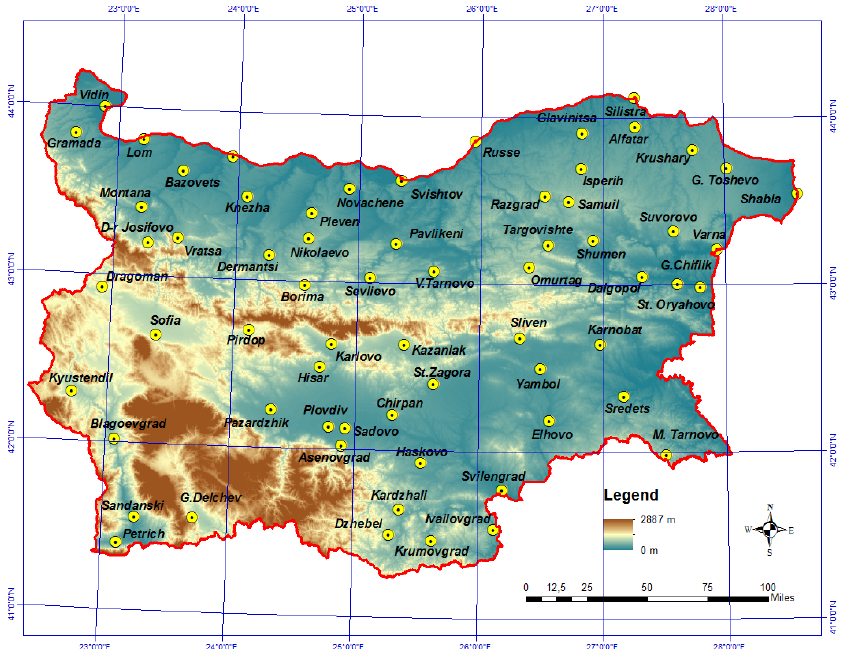
Figure 1. Meteorological stations distribution in the territory of Bulgaria using in the investigation. Table 1. Geographic coordinates—latitude, longitude, and elevation of 65 meteorological and agrometeorological stations subject of this study.